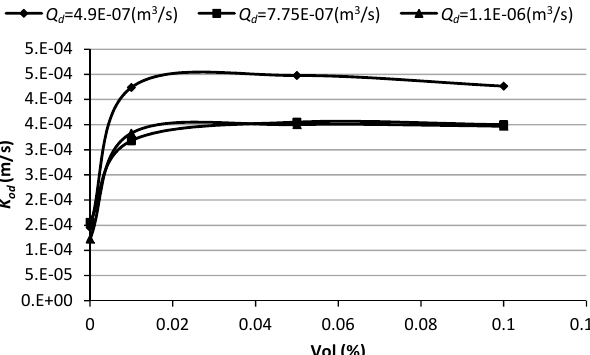
Fig. 5. Variation of mass transfer coefficient with concentration of ZrO 2 .